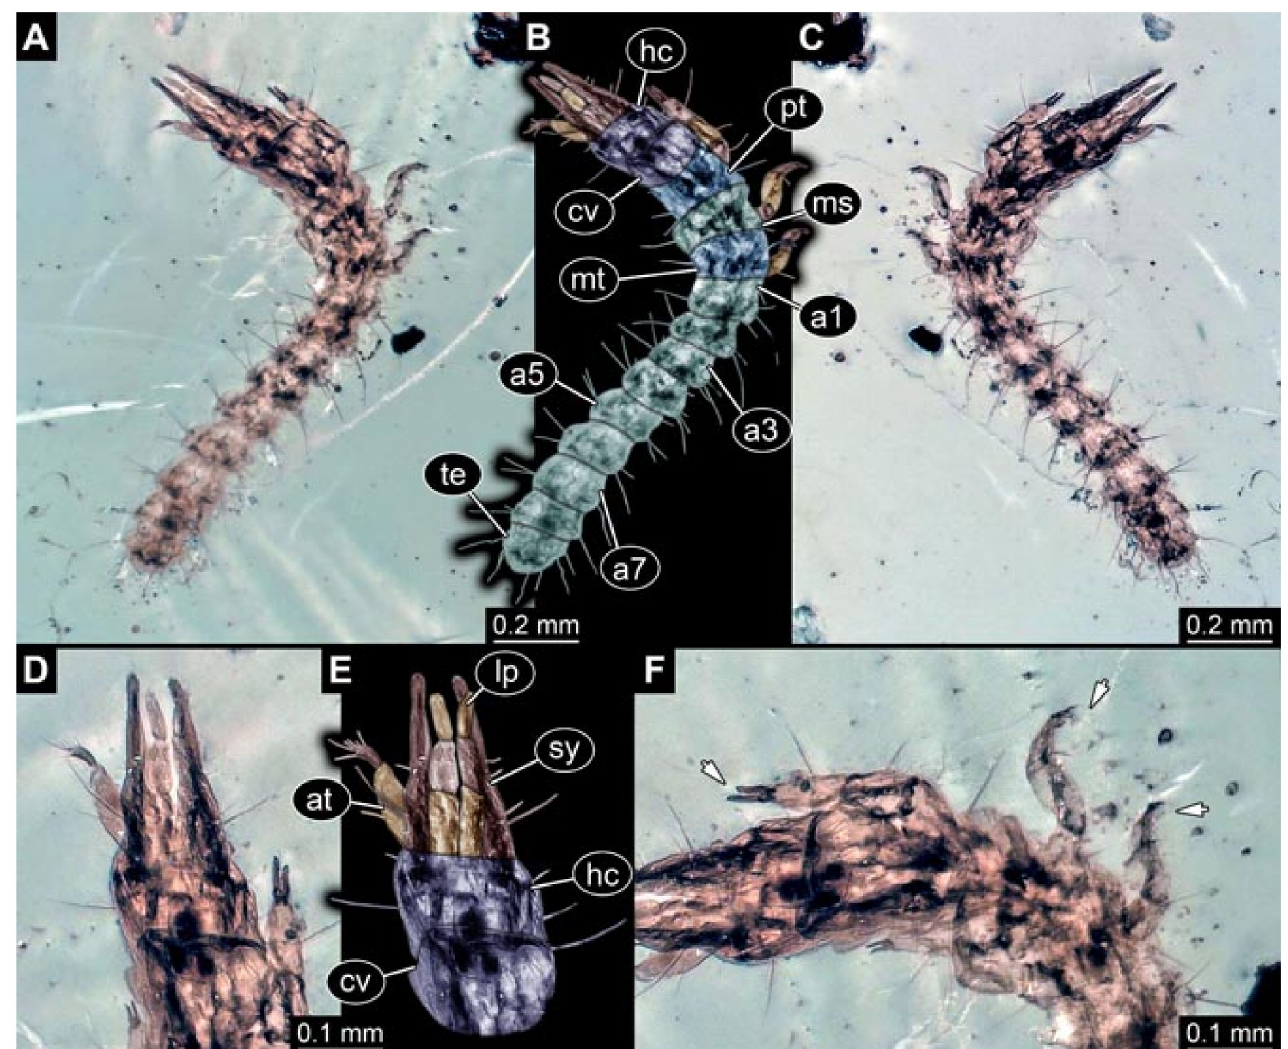
Figure 10. Specimen 5831 (BUB 3962); Myanmar amber. ( A ) Dorsal view. ( B ) Dorsal view, colour-marked. ( C ) Ventral view. ( D ) Close-up of head in dorsal view. ( E ) Close-up of head in dorsal view, colour-marked. ( F ) Close-up of trunk appendages with empodia (arrows) in ventral view. Abbreviations: a1–a7 = abdomen segments 1–7; at = antenna; cv = cervix; hc = head capsule; lp = labial palp; ms = mesothorax; mt = metathorax; pt = prothorax; sy = stylet; te = trunk